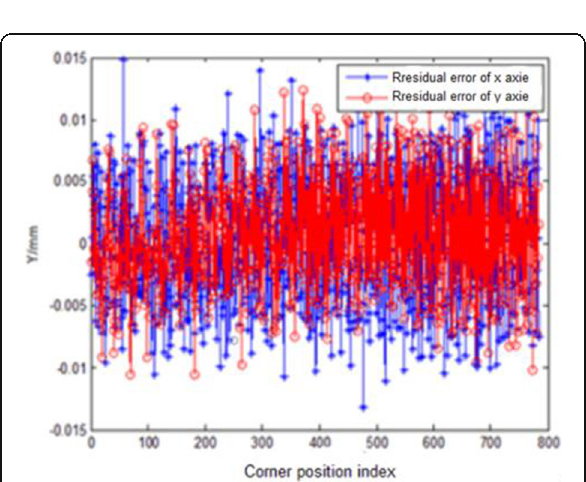
Fig. 6 Projection measurement error